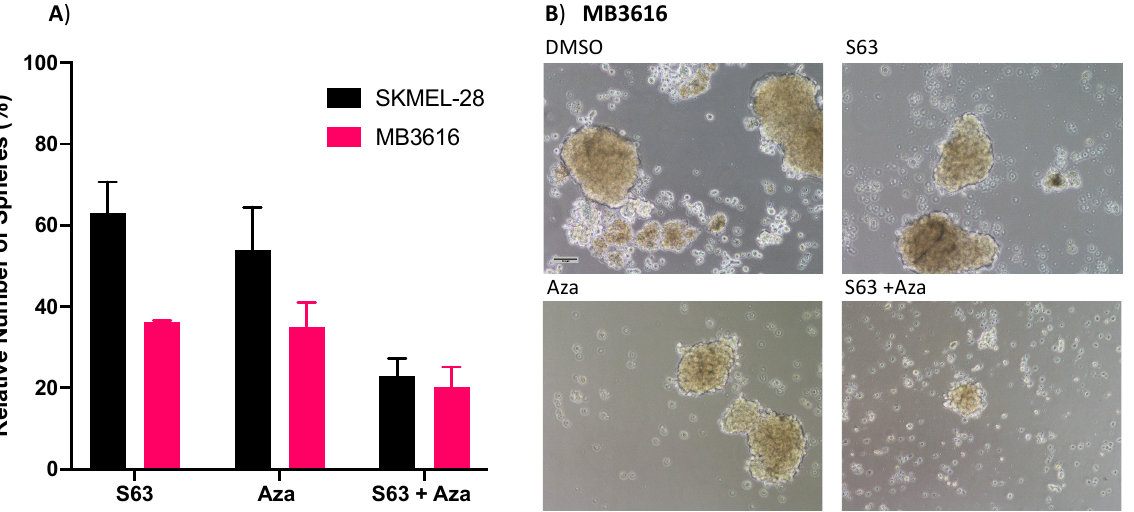
Figure 6. S63845 plus AZA treatment disrupts sphere formation. ( A ) Quantification of primary spheres after 48 h of indicated treatments. Y axis represents sphere number relative to DMSO control, set to 100%. X axis indicates treatment. Error bars represent +/ − SEM. ( B ) Brightfield images of representative wells of MB3616 spheres after 48 h of indicated treatment. Scalebar represents 100 um.